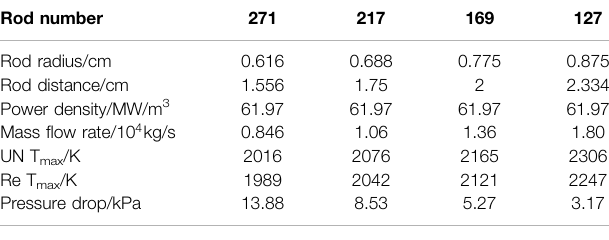
TABLE 2 | Summary of simulated rod bundle parameters in power density fi xed analysis. Rod number 271